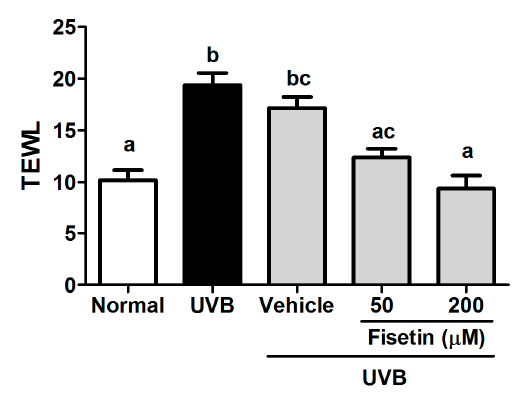
Figure 1. Effect of fisetin on transepidermal water loss (TEWL) in the ultraviolet B (UVB)-irradiated hairless mice at the 10th week. a–c: Values not followed by a common letter are significantly different ( p < 0.05).